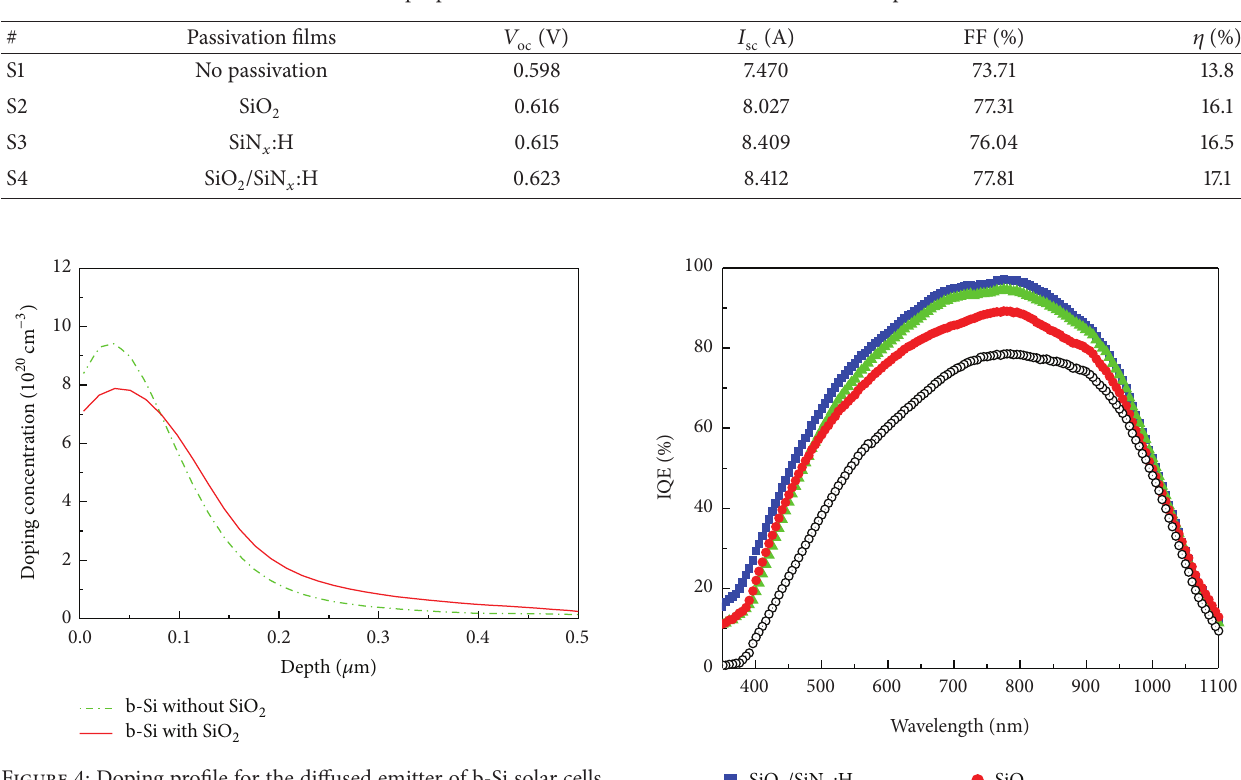
:H, and SiO 2 /SiN :H stacks x x